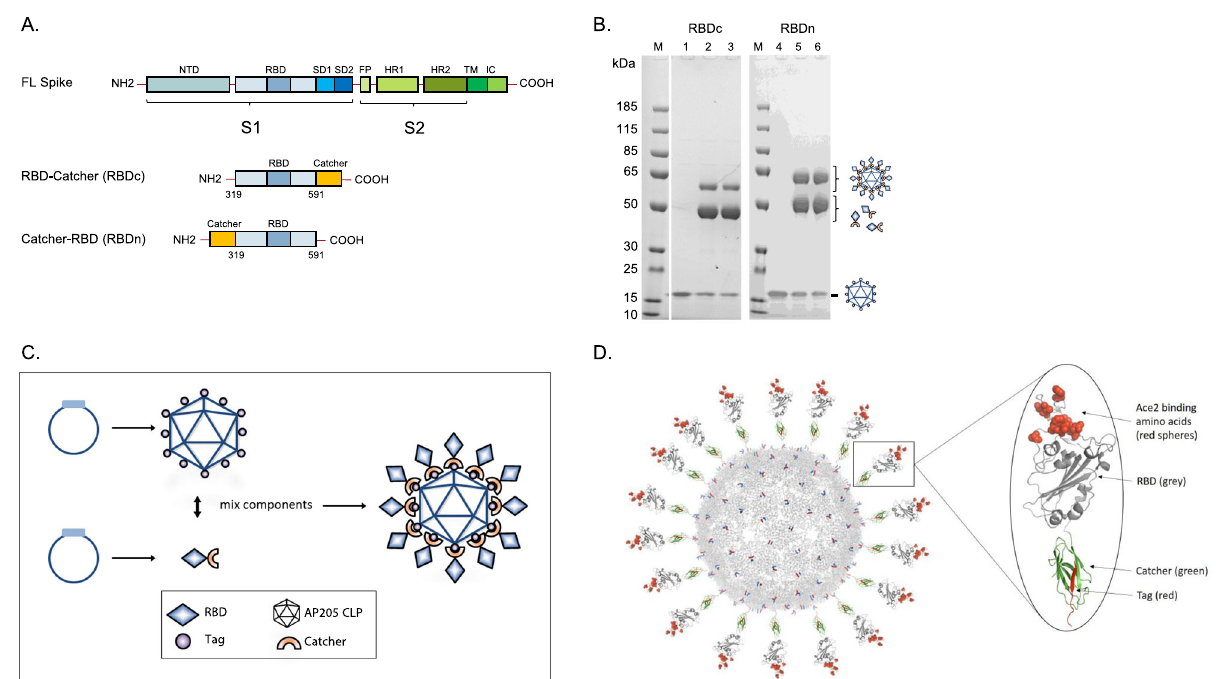
Fig. 1 RBD-CLP vaccine design and characterization. a Schematic representation of the complete SARS-CoV-2 spike protein including the two RBD- Catcher antigen designs. NTD = N-terminal domain, FL = full-length, RBD = receptor-binding domain, SD1 = subdomain 1, SD2 = subdomain 2, FP = fusion peptide, HR1 = heptad repeat 1, HR2 = heptad repeat 2, TM = transmembrane region, IC = intracellular domain. b Individual vaccine components on a reduced SDS-PAGE. M: marker, lane 1: unconjugated Tag-CLPs (16.5 kDa), lane 2: RBDc-CLP conjugation after overnight incubation at 4 °C (60 kDa),